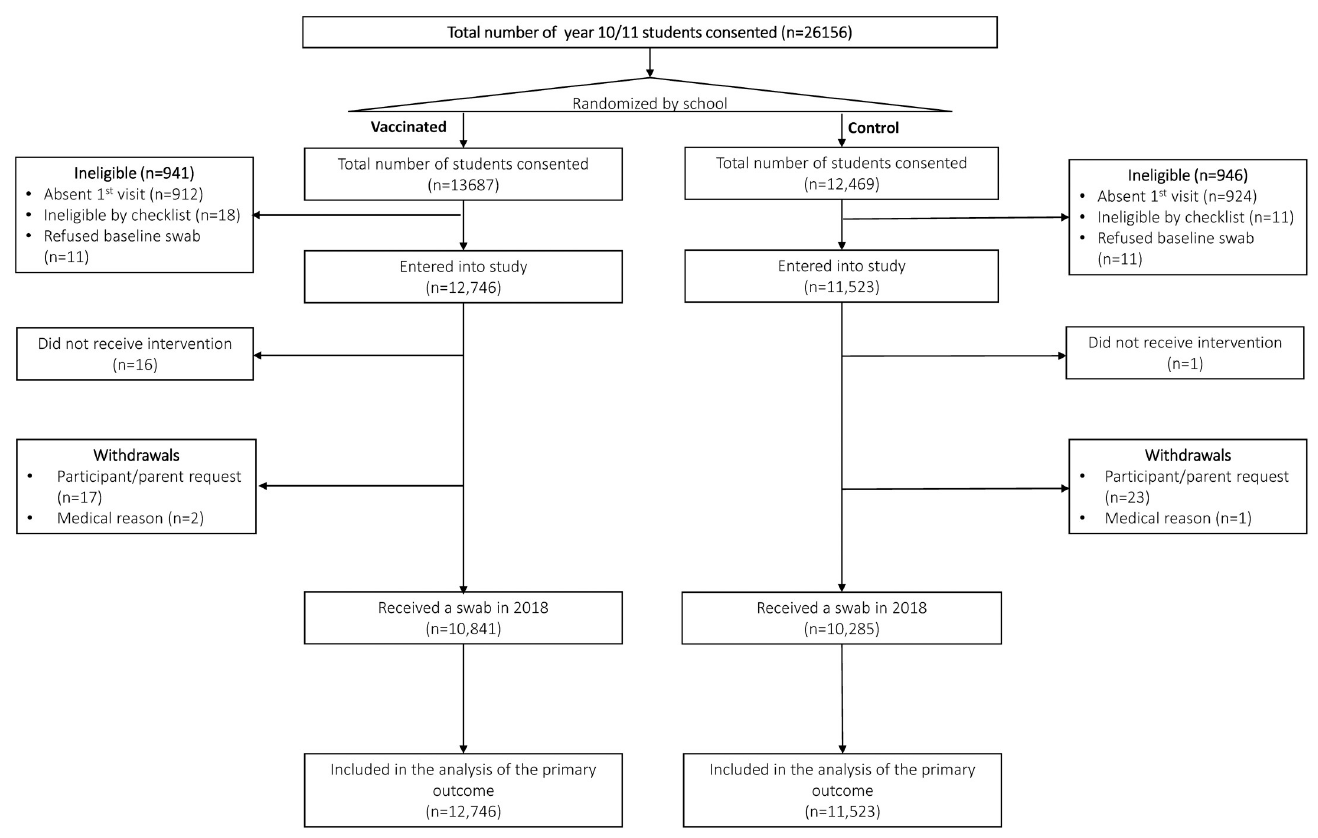
Fig 1. Flow chart for inclusion of schools into